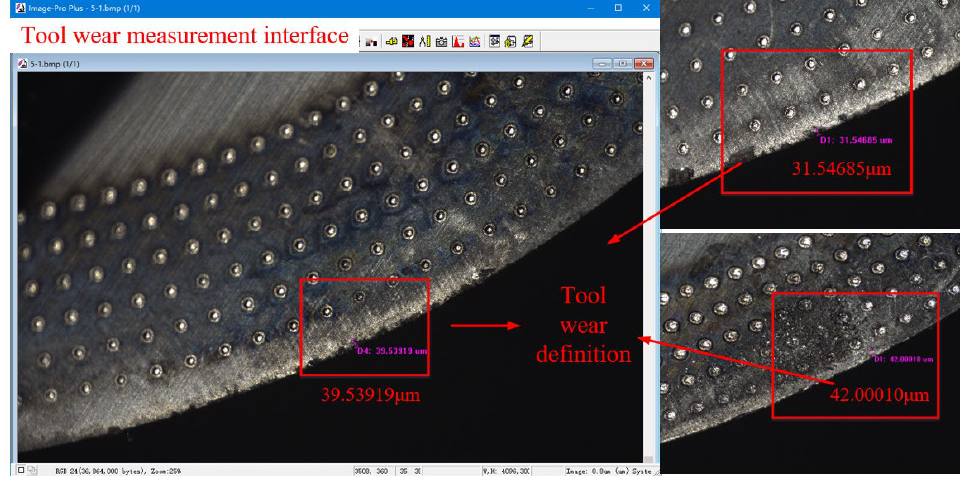
Figure 9. Tool rake face wear measurement.